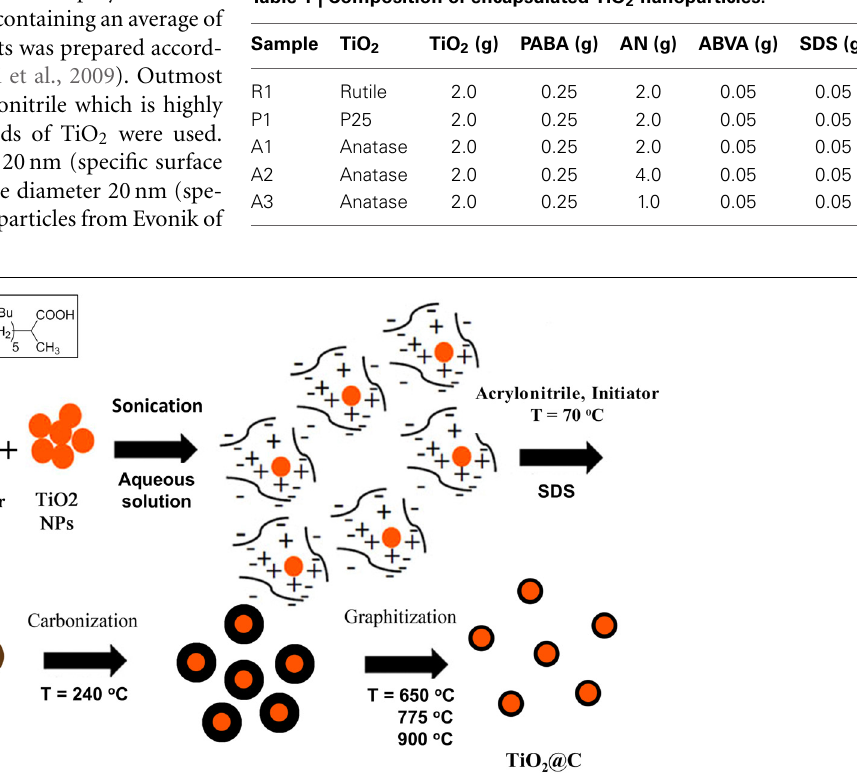
FIGURE 1 | Process for the formation of TiO 2 @C nanoparticles. The first step is the dispersion of agglomerated TiO 2 nanoparticles in water with a small amount of PABA dispersant. Electrostatic interaction occurs between positively charged TiO 2 surface and negatively charged PABA.